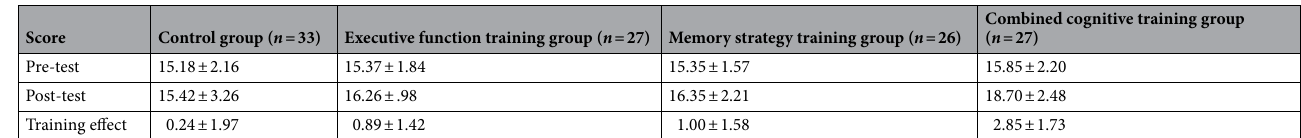
Table 5. Differences between the montreal cognitive assessment scale (MoCA) scores before and after intervention (mean [ M ] ± standard deviation [ SD ]).